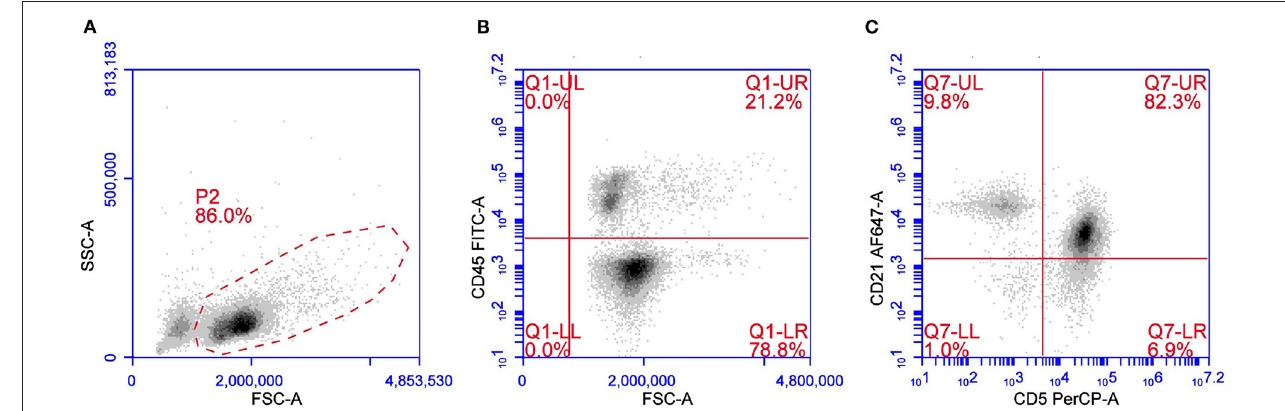
FIGURE 2 | Flow cytometric presentation of a TZL. (A) Forward scatter (FSC) vs. side scatter (SSC) plot after doublet exclusion showing a prevalent population of medium sized cells. (B,C) FSC vs. CD45 plot (B) and CD5 vs. CD21 plot (C) of P2-gated cells showing that medium-sized cells are CD45–CD5 + CD21 +